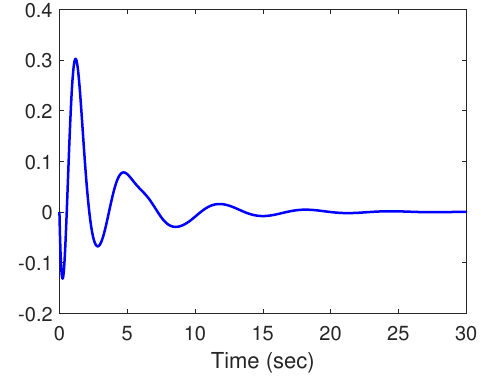
Figure 6. The trajectory y ε ( t ) .